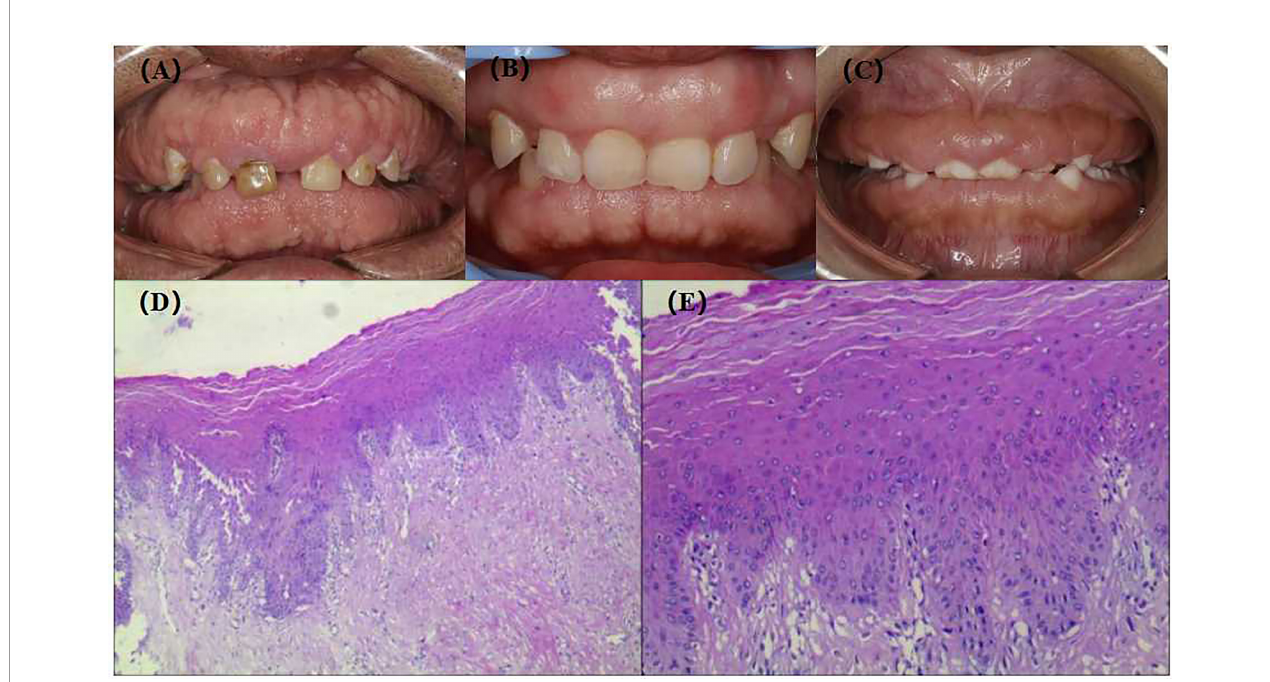
FIGURE 3 | Extra-oral images, intra-oral images and HE staining of gingival tissue of patients with NHGF. (A) II-1, 63 years old; (B) III-2, 35 years old; (C) IV-1, 5 years old; (D) HE staining of gingival tissue III-2(40×); (E) HE staining of gingival tissue